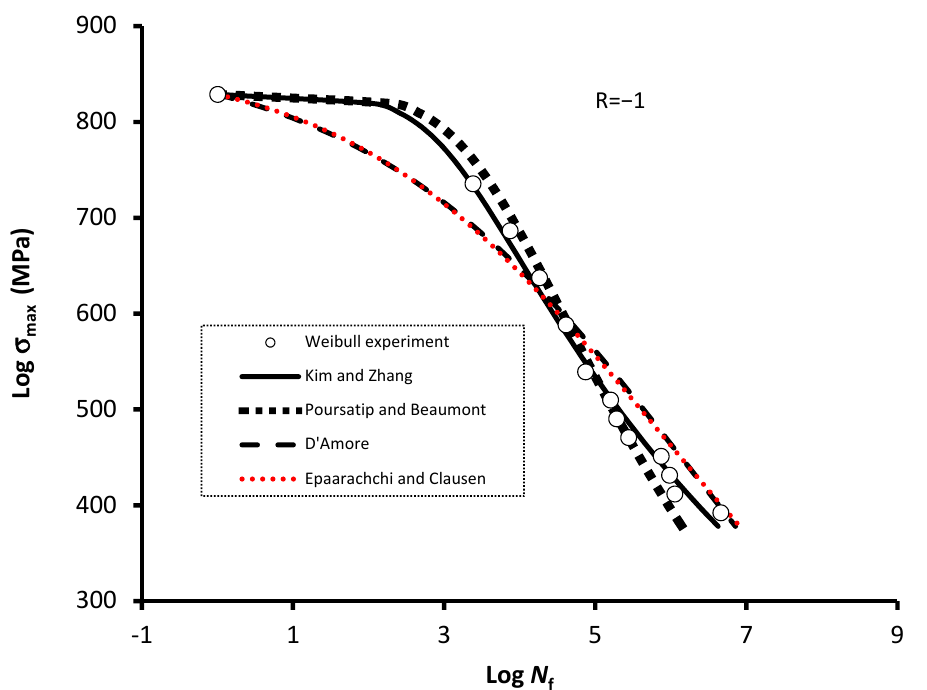
Figure 10. Weibull experimental data at R = − 1 [18] plotted with data points having a probability of 50% failure for Bofors FR 76 Steel rotating beam test with σ uT = 829 MPa, and S-N curves obtained from: Kim and Zhang model with α = 3.63 × 10 − 39 , β = 11.809, and N 0 = 1; Poursatip and Beaumont model with α = 17,000 and added N 0 = 1; D’Amore model with α′ = 0.053 and β = 0.2; and Epaarachchi and Clausen model with α′ = 0.0007 and β = 0.245.